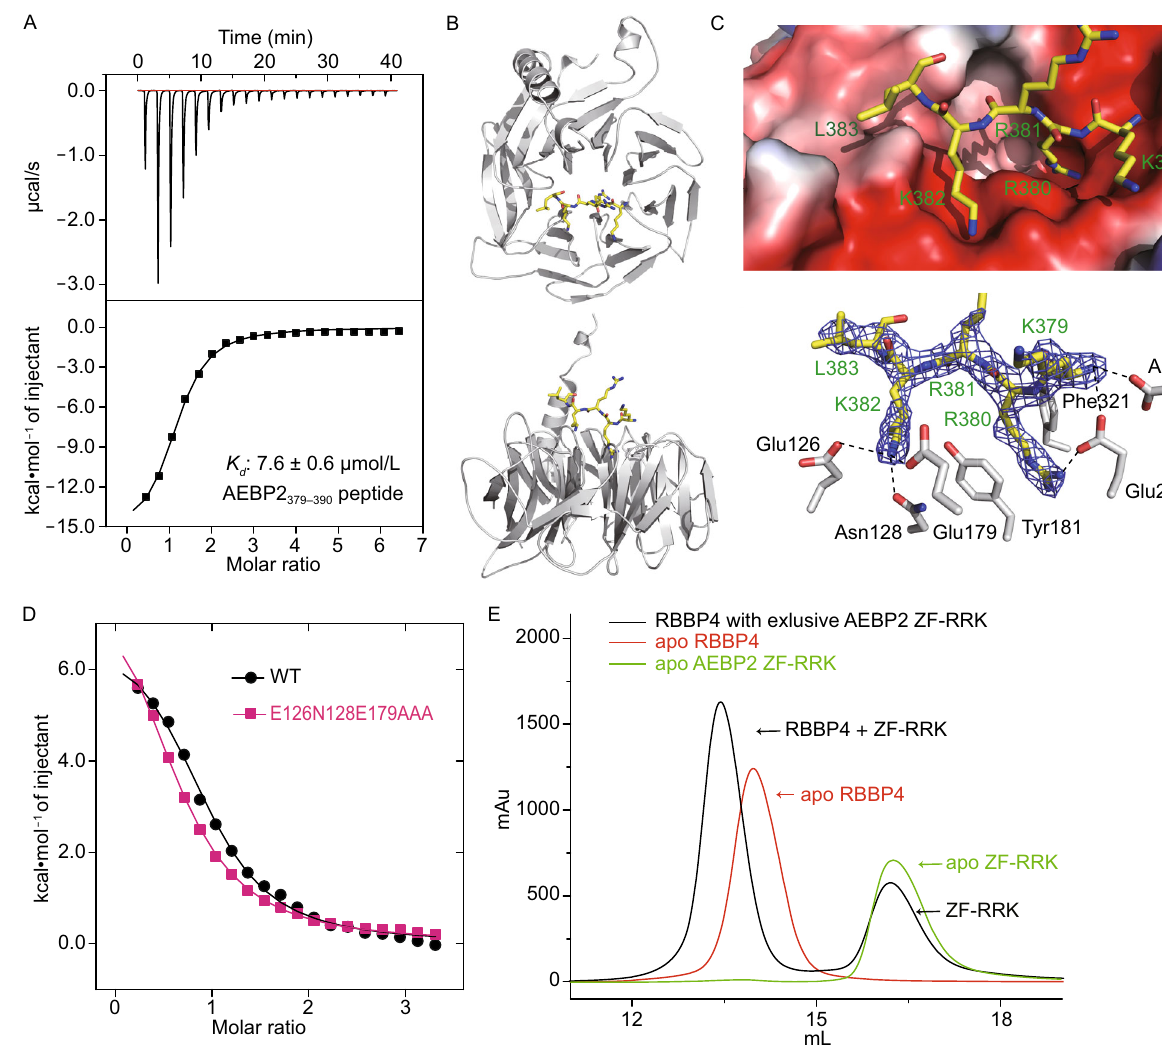
Figure 2. Both the three zinc fi ngers and RRK rich motif interact with RBBP4 . (A) Determination of the af fi nity of AEBP2 379 – 390 peptide for the RBBP4 protein using ITC. Data were fi tted to a one-site binding model using Origin 7, and calculated binding parameters were Δ H = − 15,890 ± 395 cal/mol, and Δ S = − 29.9 cal/mol/deg. (B) Two orthogonal views of RBBP4 bound to the AEBP2 379 – 390 peptide. The AEBP2 379 – 390 peptide is shown in yellow, with RBBP4 in gray. (C) Recognition of the AEBP2 379 – 390 peptide by RBBP4. Electrostatic surface potential representation of the binding pocket with the AEBP2 379 – 390 peptide (shown in yellow stick model) (upward) and a simulated annealing omit map (blue) contoured at 1.0 σ shows the electron density for the AEBP2 379 – 390 peptide bound to RBBP4 (downward). The AEBP2 379 – 390 peptide (labeled in green) is shown in yellow stick model, with RBBP4 residues (labeled in black) in gray stick model. Hydrogen bonds and salt bridge interactions are delineated by black dashed lines. (D) Determination of the af fi nity of AEBP2 ZF1 – 3 for RBBP4 of wild type and Glu126Ala/Asn128Ala/Glu179Ala mutation using ITC, respectively. Data were fi tted to a one-site binding model using Origin 7. (E) The overlaid curves of apo RBBP4, apo AEBP2 ZF-RRK and mixture of RBBP4 with exccesive AEBP2 ZF-RRK by gel fi ltration assays on a same SuperdexTM 200 10/300 GL